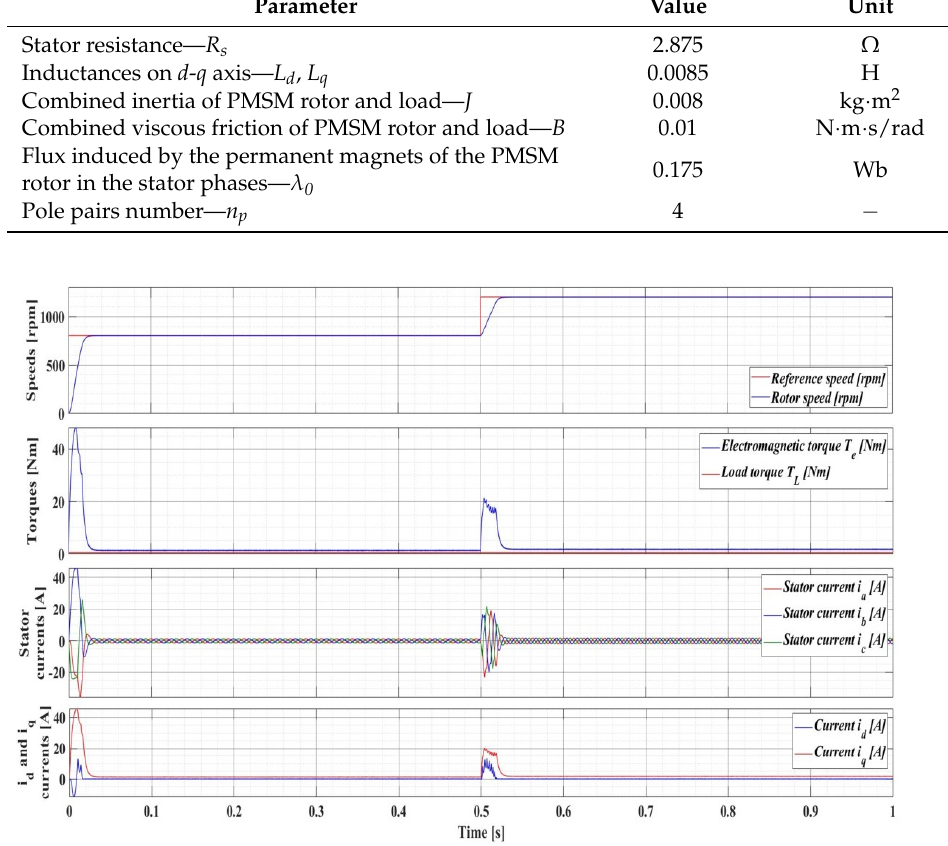
Figure 3. Time evolution parameters of the PMSM control system based on FOC-type strategy: ω ref = [800, 1200] rpm and T L = 0.5 Nm.